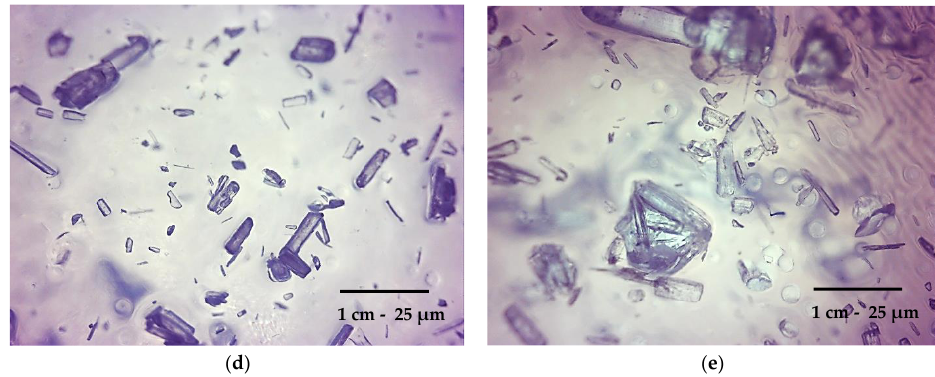
Figure 10. Images of samples: 0 ( a ); 0.25 g_Tamoxifen ( b ); 0.50 g_Tamoxifen ( c ); 1.78 g_complex ( d ); and 3.56 g_complex ( e ).